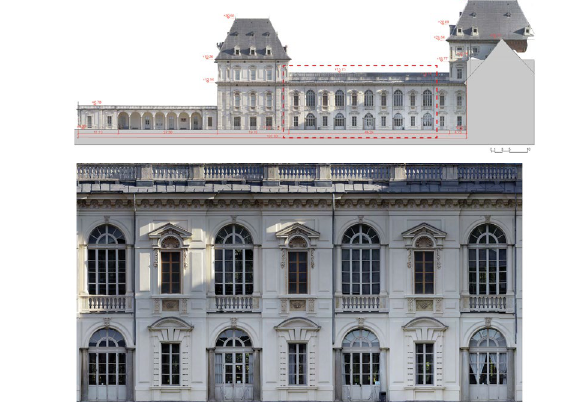
Figure 14. Architectural drawings (elevations and sections) created starting from the acquired data.